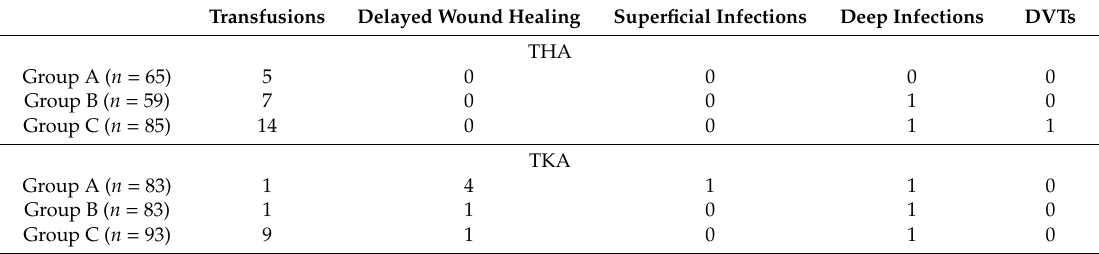
Table 3. Transfusions and adverse events in total hip arthroplasties (THAs) and total knee arthroplasties (TKAs).